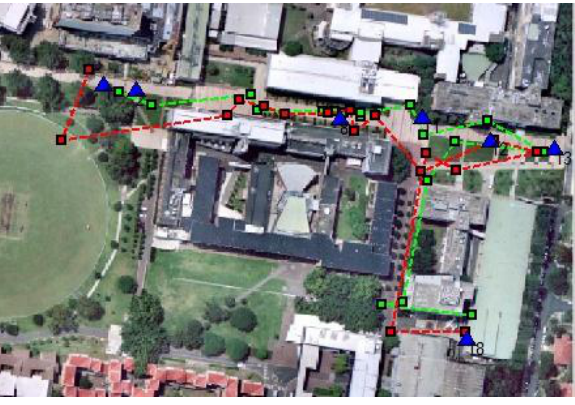
Figure 18. Red dash line shows the trajectory obtained from the build-in GPS receiver, while green dash line shows the calculated results; blue triangles represent the true GCPs that user passed by.